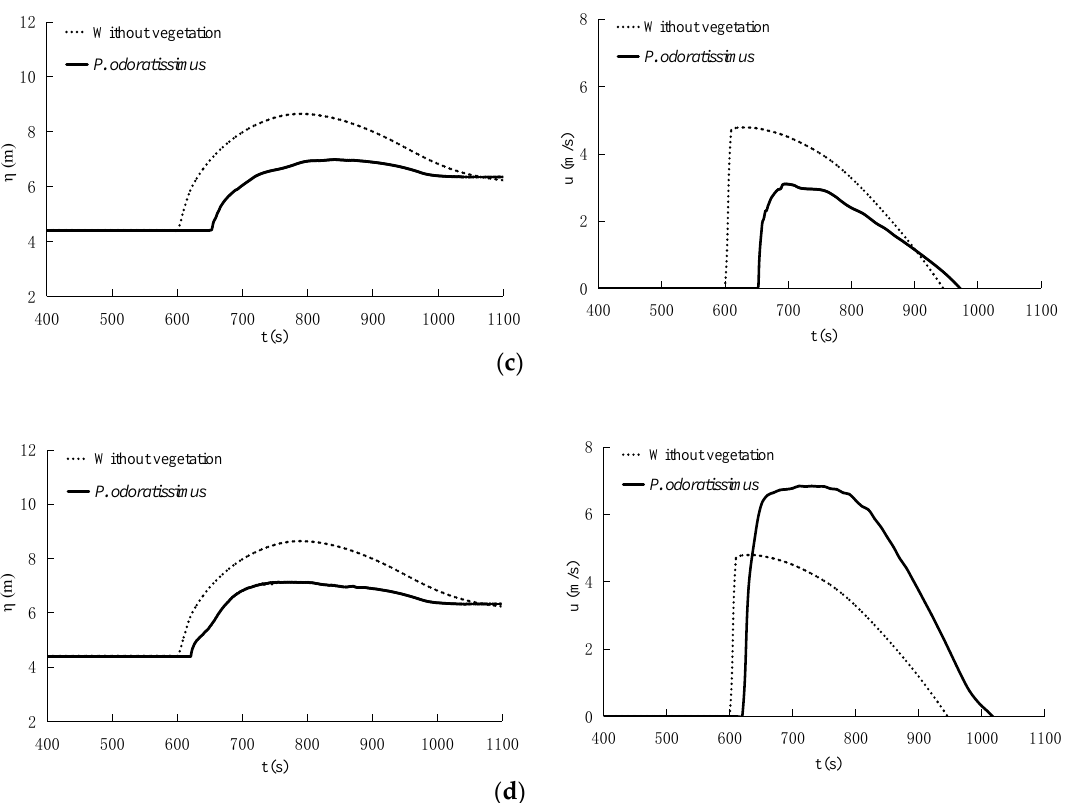
Figure 13. Temporal variation of water surface elevations and flow velocities at four predicted stations of Case 1, ( a ) G1, ( b ) G2, ( c ) G3, ( d ) G4.